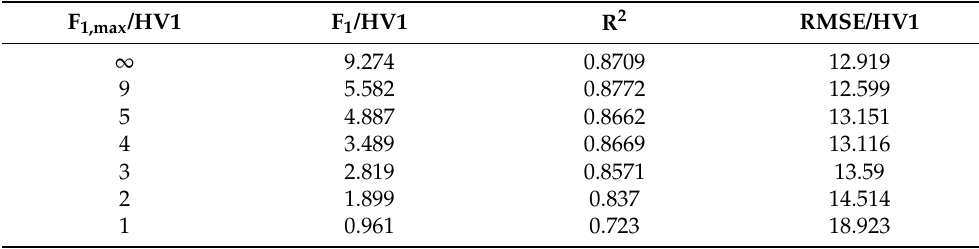
Table 5. Coefficient of determination and standard error in dependence of the maximum error effect for regression analysis of